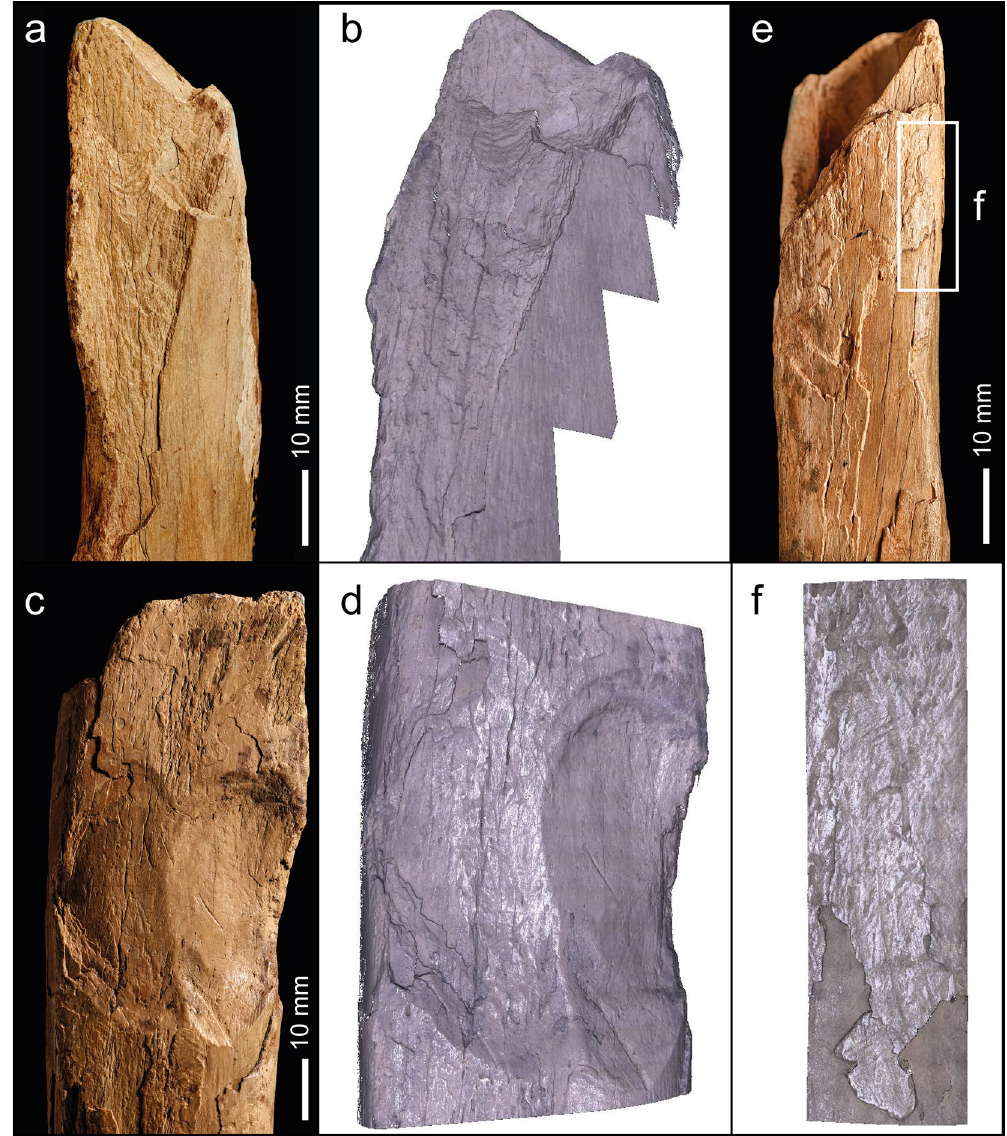
Figure 8. NHMUK PA E 7492—Photographs and Alicona images of flake scars ( a – d ) and post-depositional abrasion (scratches and polish), the latter occurring on both flake scars and on weathered surfaces. Details of the weathering show the sequential loss of layers of the outer surface of the cortical bone ( e , f